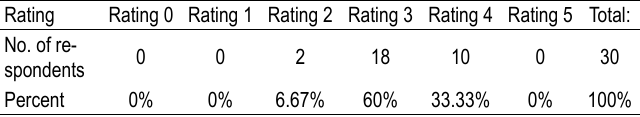
Table 4. condition of patients before therapy